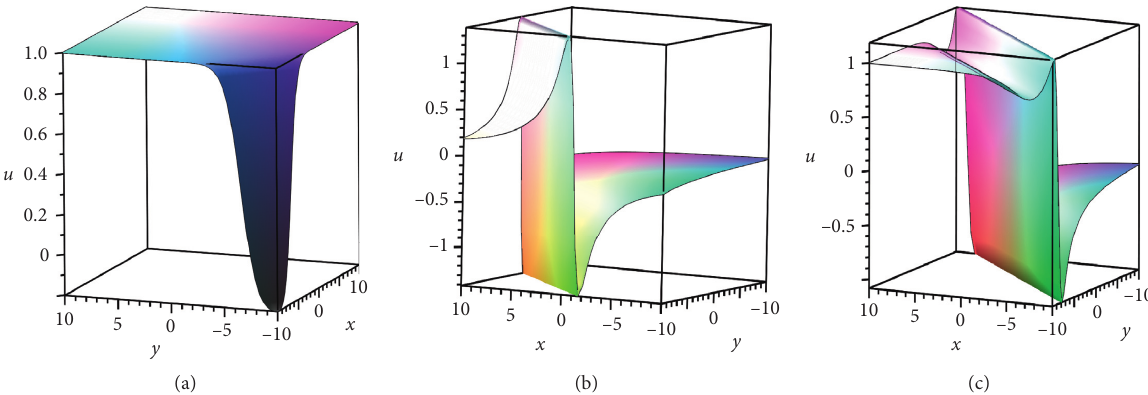
� 1, p � 1, k � 1, a � 1, α � 1, β � 1; b : t � 0, 1 1 1 5